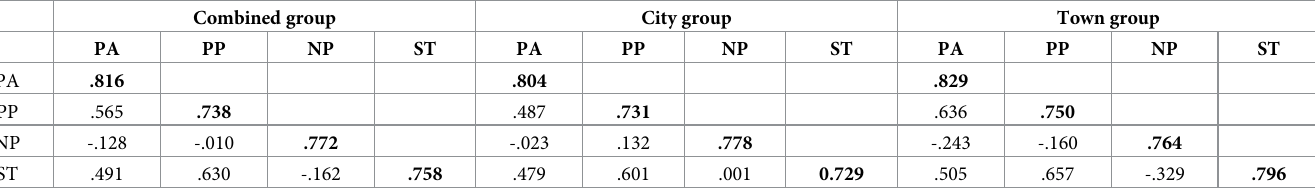
Table 6. Discriminant validity